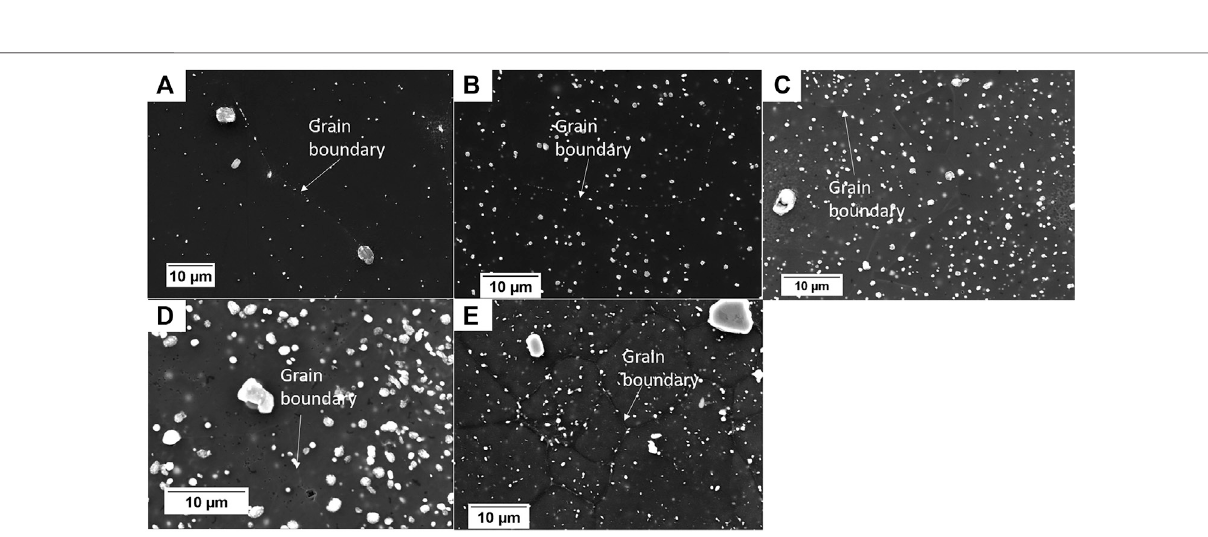
Frontiers in Materials |